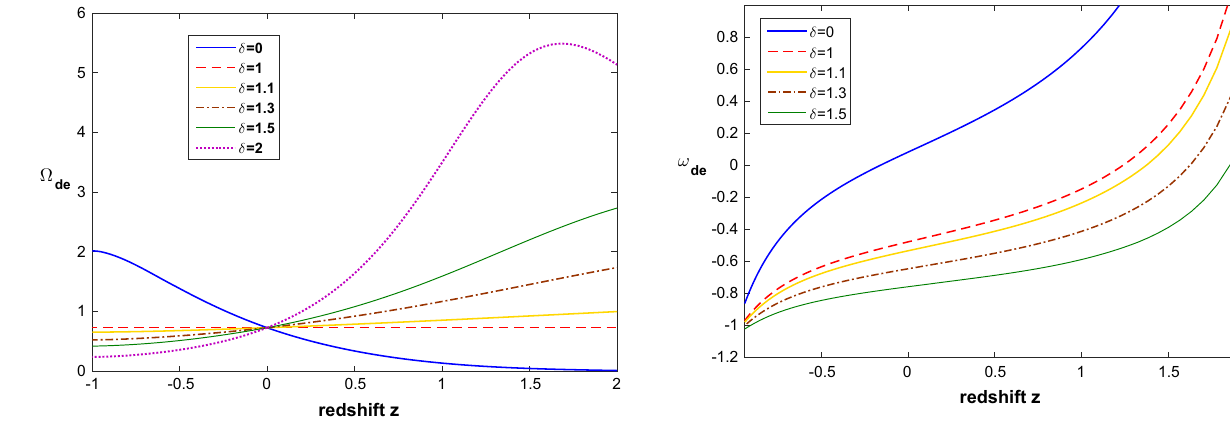
Fig. 1 Plot of Ω de of non-interacting THDE model versus redshift z for β 1 = 7 . 1, β 2 = 2 . 15, w = 1000, Ω 0